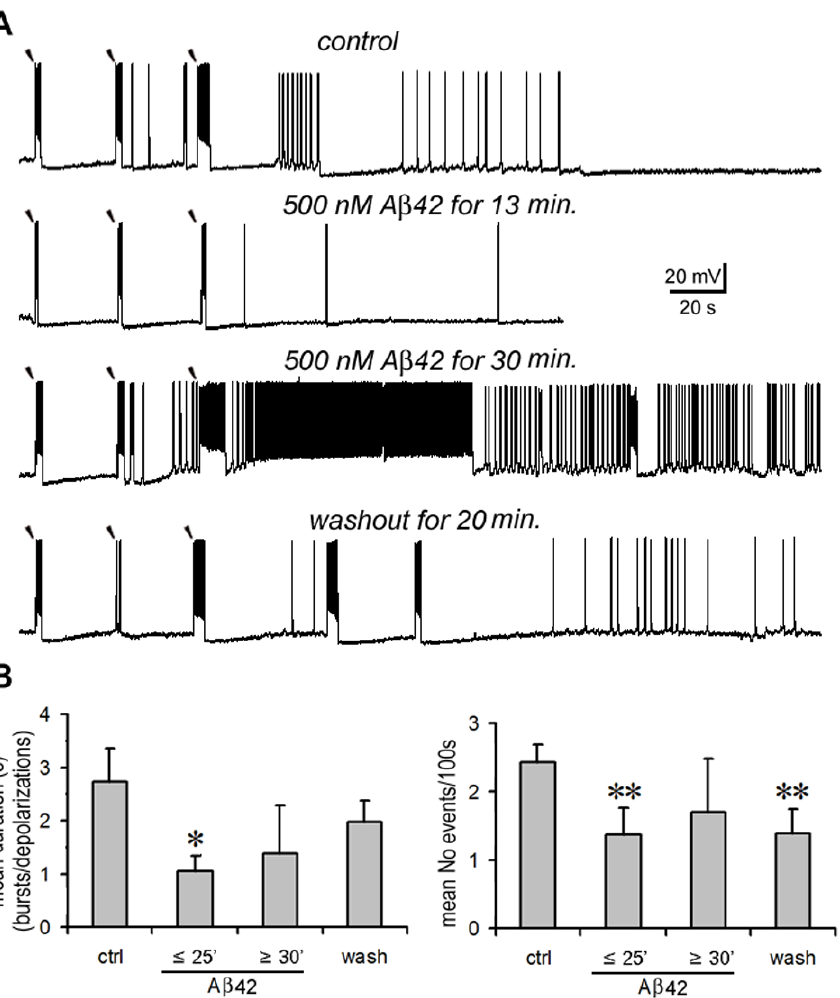
Figure 4. High dose A b 42 has a biphasic effect on electrical network activities. A. A representative experiment. Under calcium-free conditions, a PC was recorded after delivery of three extracellular stimuli. The bursts became briefer after 500 nM A b 42 was applied for 13 min. (2nd panel). After A b was applied for $ 30 min., the responses became paradoxically stronger as evidenced by the broader bursts and tonic firing that followed the 3 rd evoked burst (3 rd panel). Spontaneous responses were also enhanced (followed the 2 nd evoked burst in the 3rd panel). The excessive activity recovered on washout for 20 min. (lower panel). B. Statistical analysis: Compared with the control, the average duration (left panel) and occurrence (right panel) of evoked responses was significantly reduced after 500 nM A b 42 was applied for # 25 min. (duration: p =0.017; occurrence: p =0.002, n =10, not including the cells that later showed tonic responses during prolonged application). The inhibition disappeared with A b applications for more than 30 min. (duration: p =0.509; occurrence: p =0.137). On washout, responses were similar to the control (duration: p =0.332) but appeared less frequently (occurrence: p =0.006). Note: ‘‘*’’, p , 0.05; ‘‘**’’, p , 0.01.